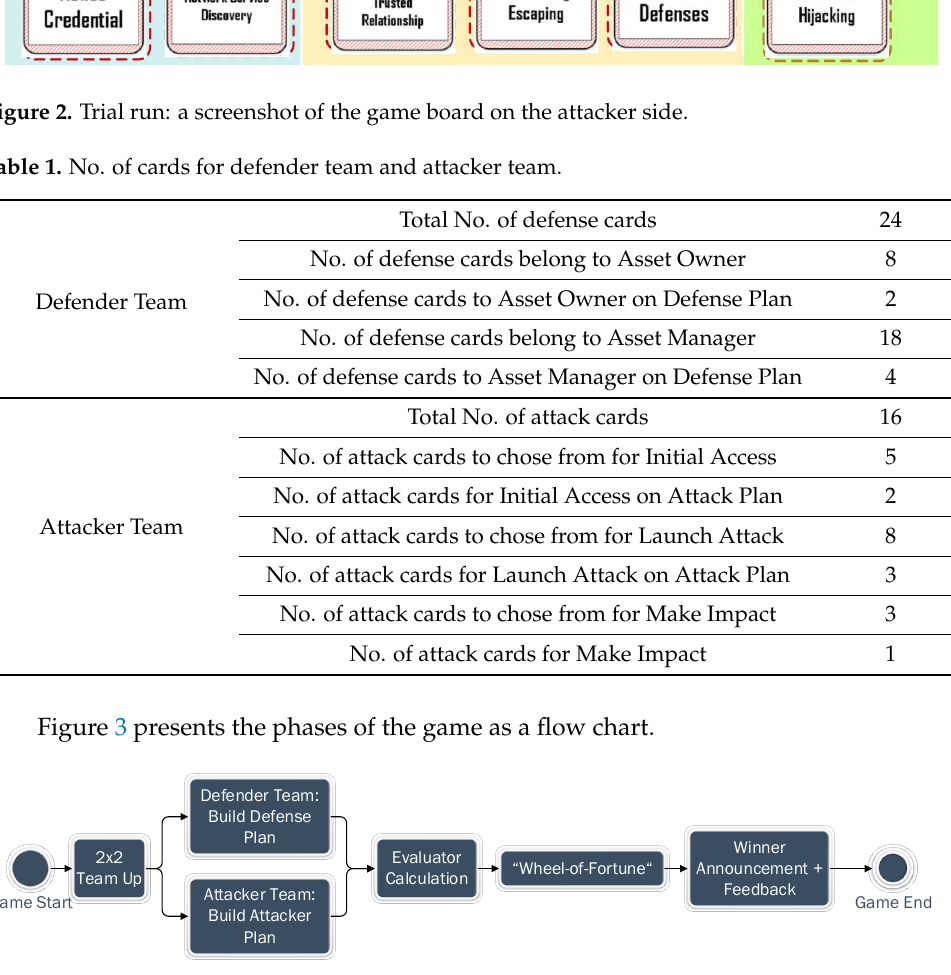
Figure 3. Game Process in